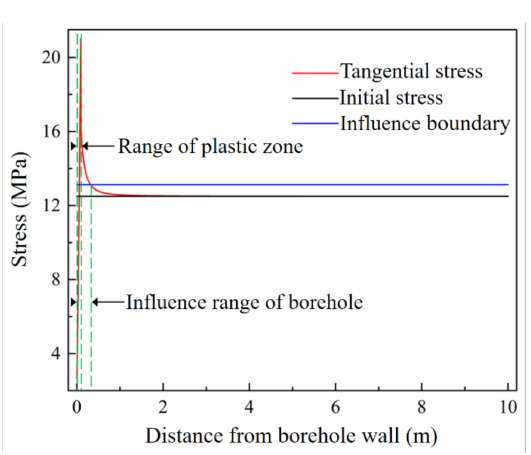
Figure 4. Distribution of tangential stress around